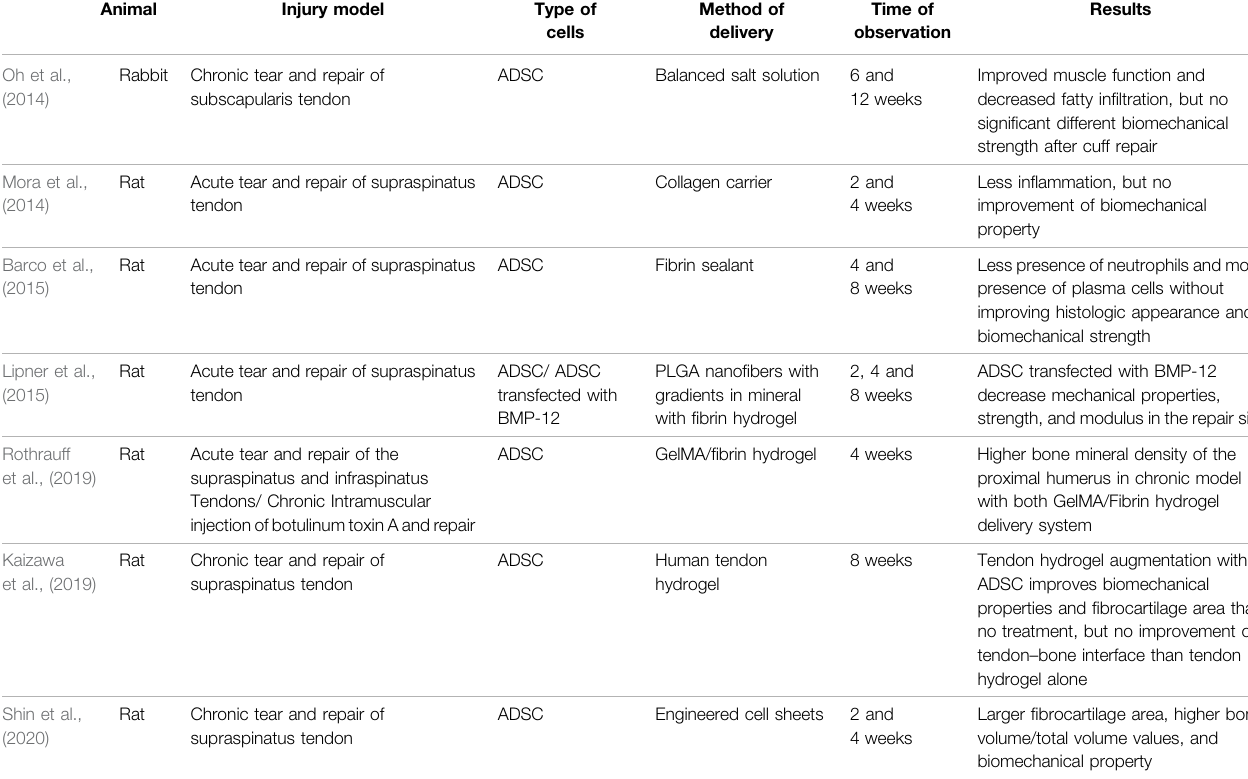
TABLE 2 | Summary of adipose stem cells for rotator cuff